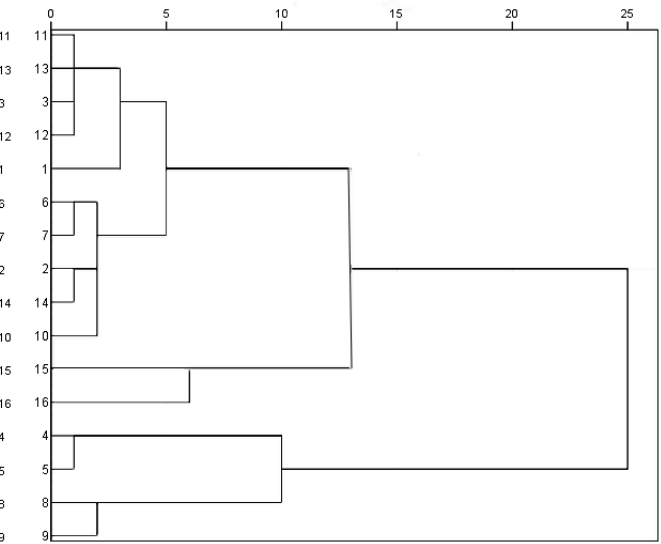
Figure 6. The cluster dendrogram of all active ingredients of 16 batches of different processing methods of S. miltiorrhiza .